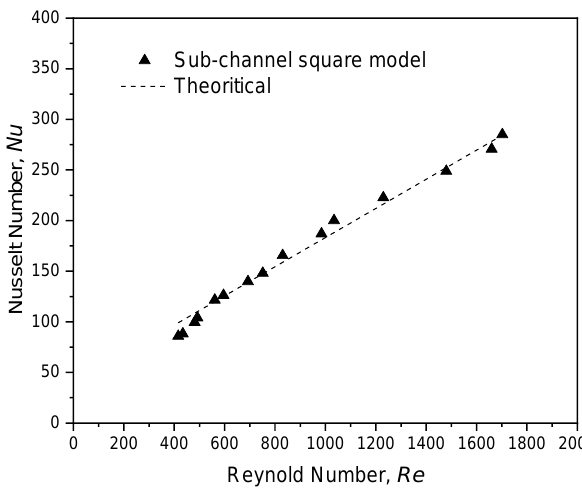
Figure 5. Validation results for Nusselt number.